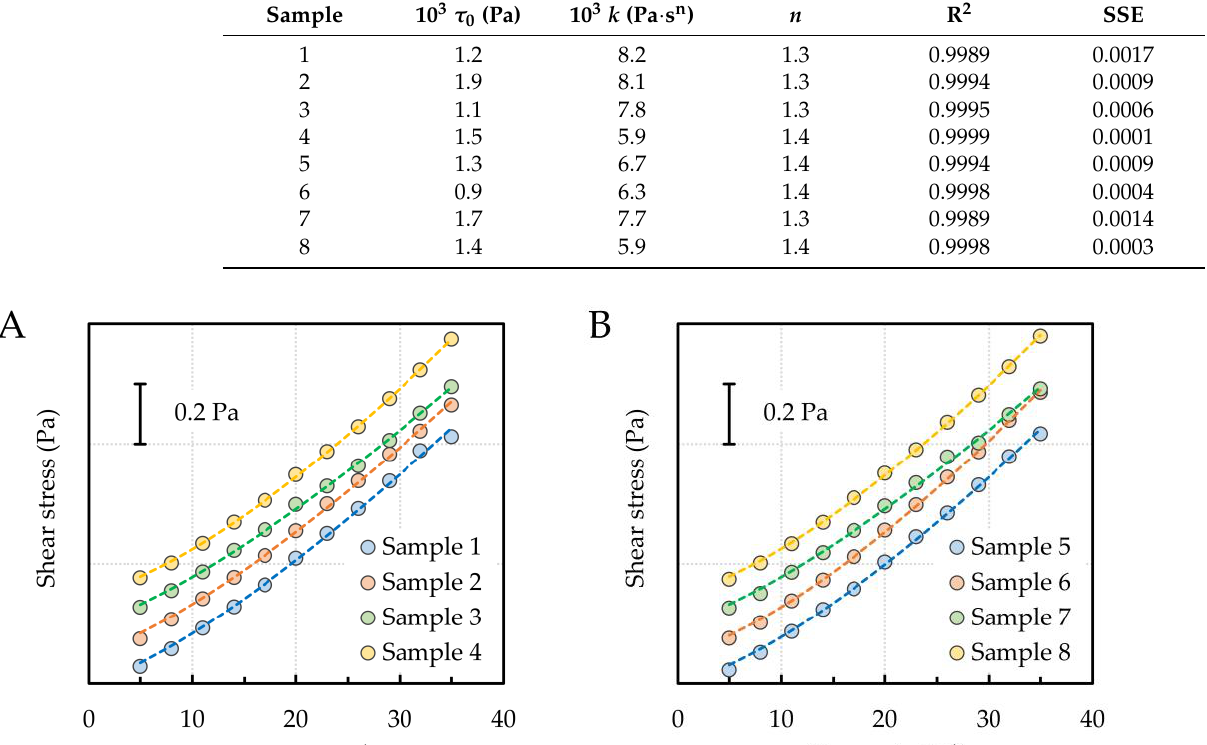
Figure 2. Flow curves fitted by the Herschel–Bulkley model (dashed lines denote the fitting curves); ( A )–samples 1–4, ( B )–samples 5–8.